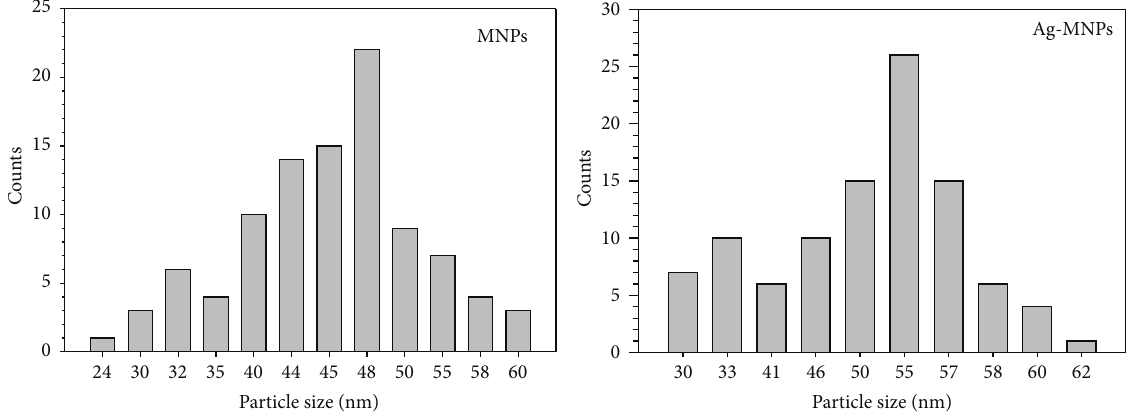
Figure 3: The size distribution histograms of MNPs and Ag-MNPs corresponding to TEM images (a)–(d) shown in Figure 2. The size distribution was obtained by counting 100 nanoparticles for each